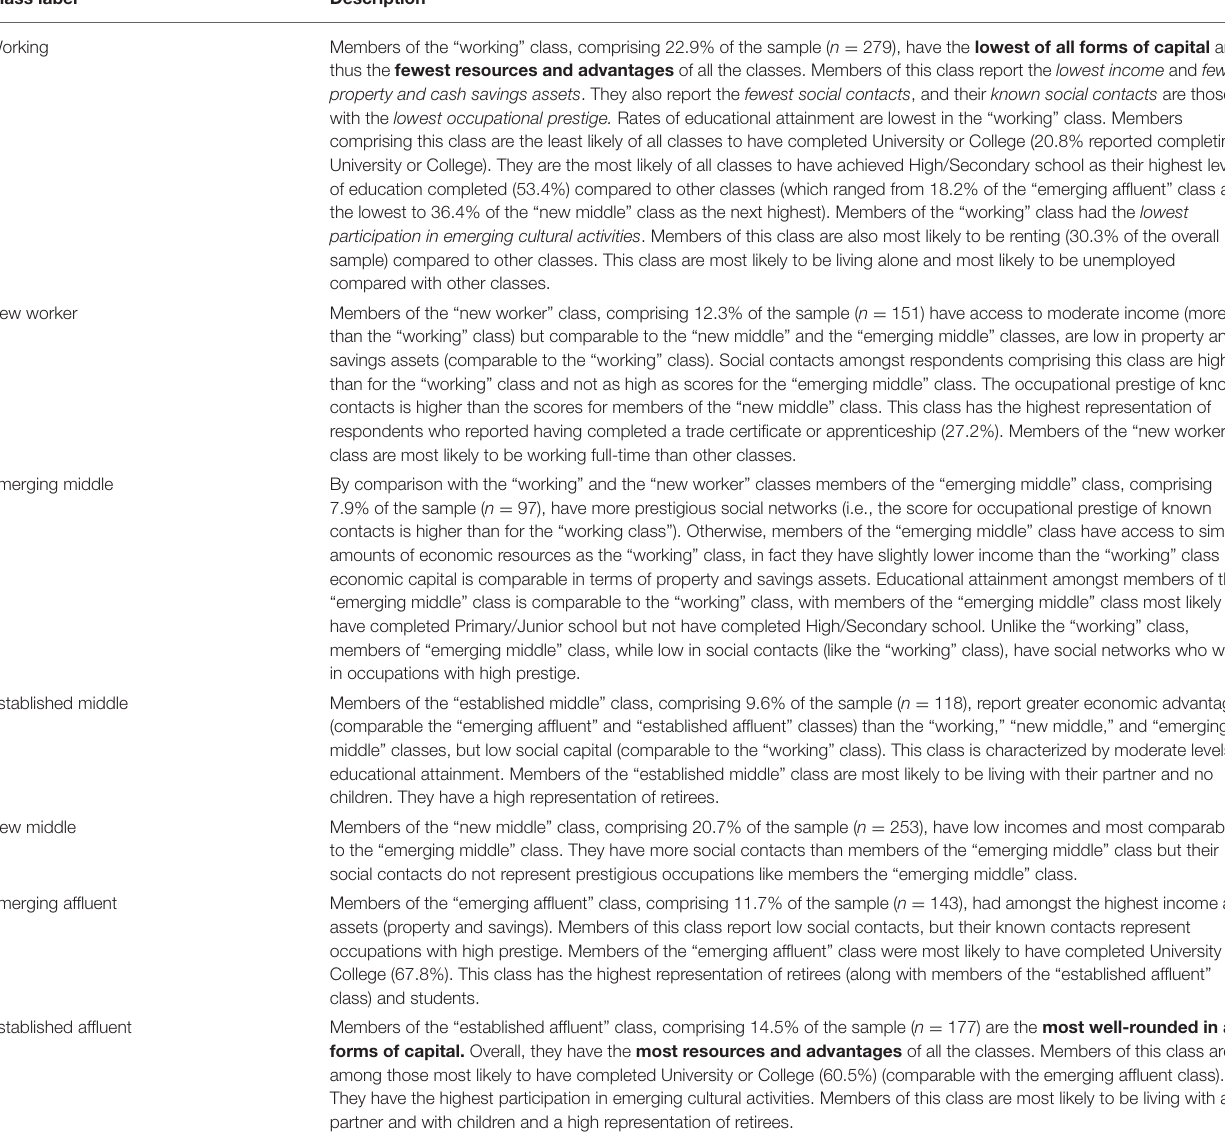
TABLE 2 | Summary of social classes resulting from LCA: labels and